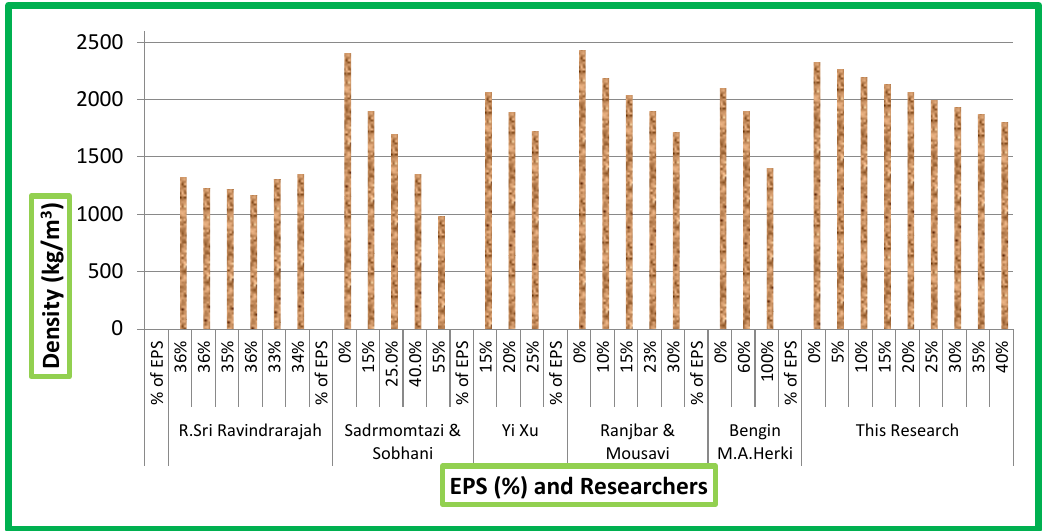
Figure 10. Comparative analysis of EPS-beads Dosage vs. EPS beads concrete Density of this study with Ravindrarajah, R. Sri. [59], Sadrmomtazi, A., et al. [60], Xu, Yi, et al. [6], Ranjbar, M. M., and Mousavi, S. Y. [61] and Herki, B. [2].